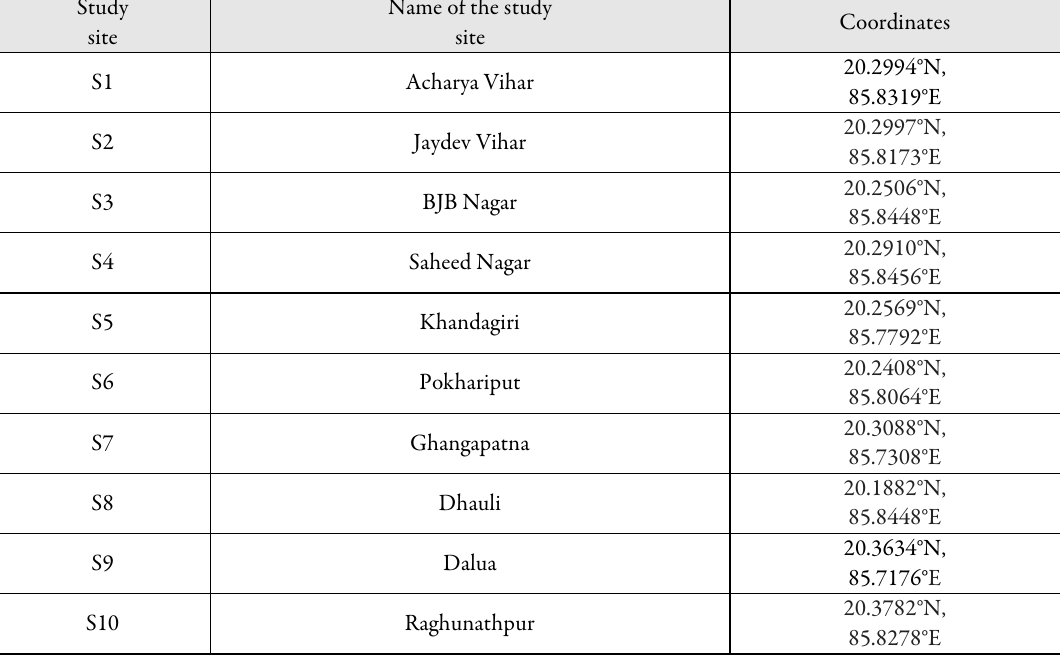
Table 1. Coordinates of study sites in